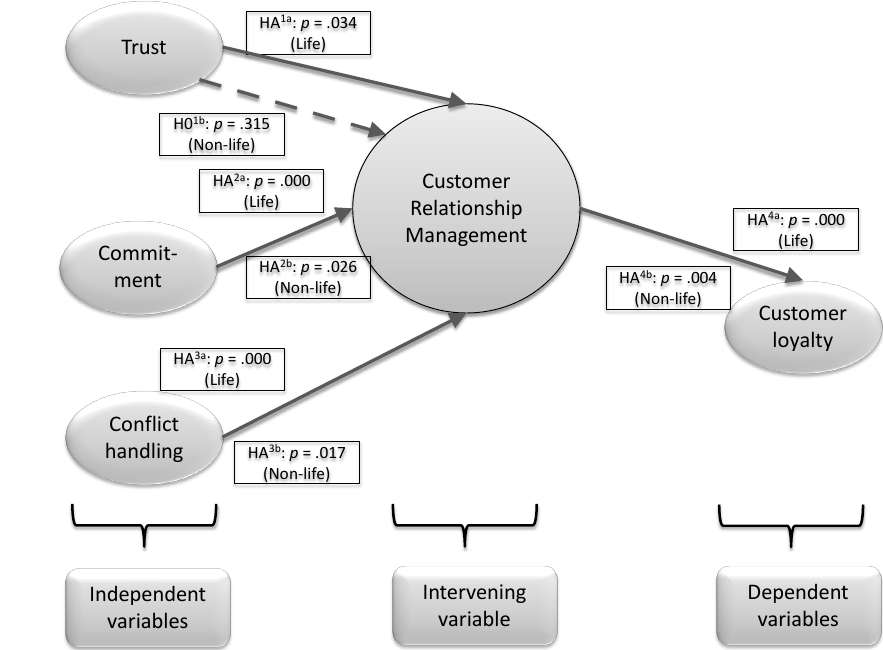
FIGURE 2: Empirical model modified - Life and non-life insurance industry Source: Researcher’s